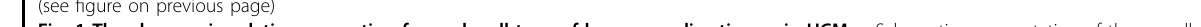
Fig. 1 The changes in relative proportion for each cell type of human cardiac tissues in HCM. a Schematic representation of the overall experimental procedure. The cardiac IVS tissues of HCM patients who underwent surgical myectomy were collected for snRNA-seq ( n = 10; 10 samples) and spatial transcriptomic assays ( n = 6; 8 tissue sections). As a control, cardiac IVS tissues from healthy heart transplant donors ( n = 2; 3 samples; the samples HEALTHY1A and HEALTHY1B were from the same donor) were subjected to snRNA-seq. b Unbiased clustering of 55,122 nuclei from all 13 samples identi fi es 9 major cell types. The nucleus count is indicated by the number in parenthesis. c UMAP plot showing the expression of the established marker genes for each cell type. d Comparison of the nucleus densities in the UMAP space between the two conditions reveals remarkable changes in the relative proportion of cell types in HCM. Nuclei were randomly sampled in equal numbers for each group ( n = 15,939). e Relative proportion of each cell type in each condition. + : expansion; – : contraction. f Heatmap showing the molecular signature of each lineage. CM cardiomyocyte, FB fi broblast, lEC lymphatic endothelial cell, SMC smooth muscle cell, vEC vascular endothelial